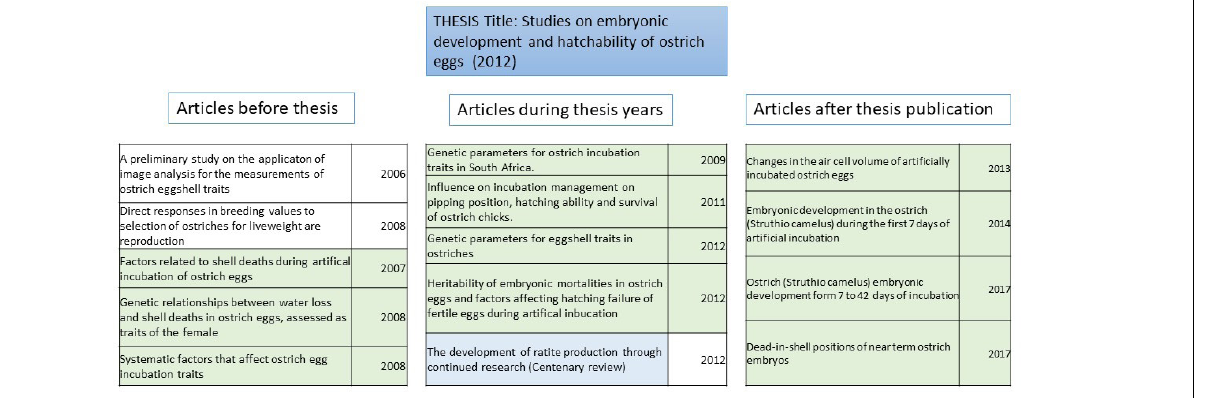
Figure 3: Illustrative example 2 of study and publication trajectory